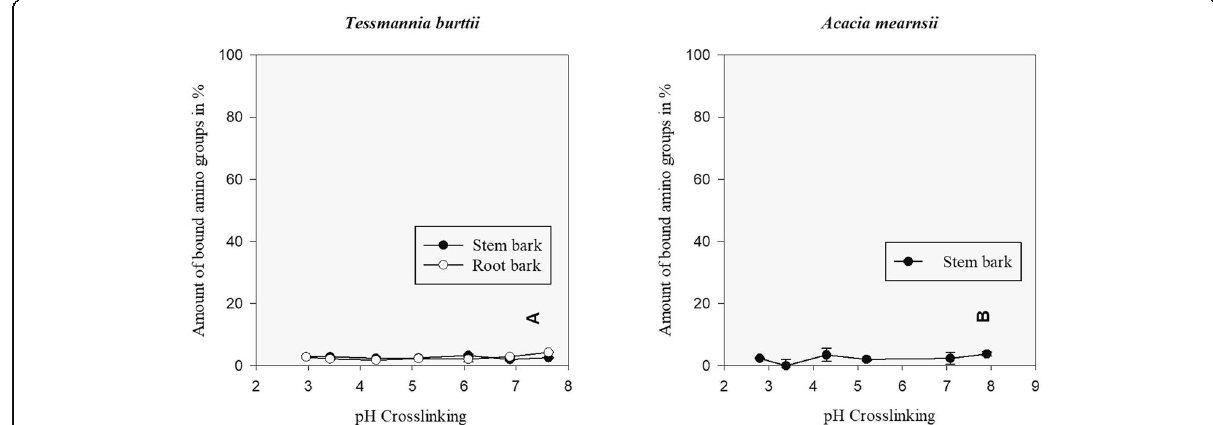
Fig. 4 Amount of bound amino-groups of hide powder cross-linked with the extracts of Tessmannia burttii ( a ) and Acacia mearnsii ( b ) extracted at 50 °C with pH dependence after acid